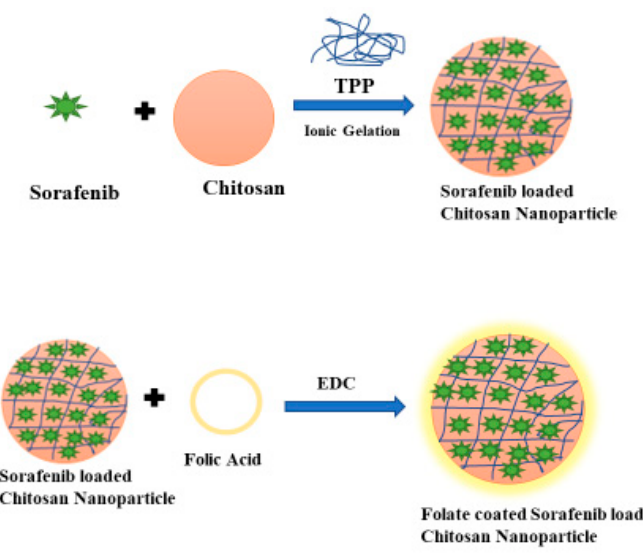
Figure 2. Schematic diagram of the synthesis steps of folic acid-conjugated chitosan Sorafenib na- noparticles.